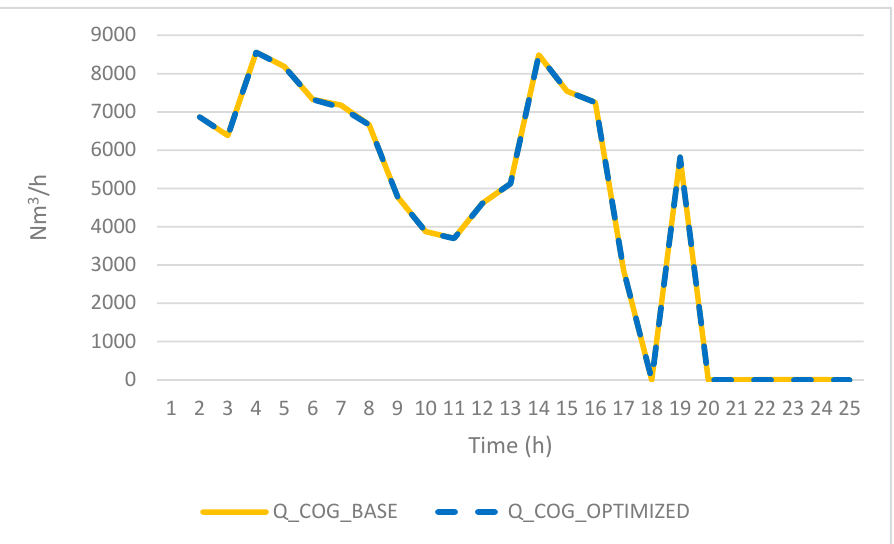
Figure 9. Base and optimized distribution COG for steam production in the planning period.